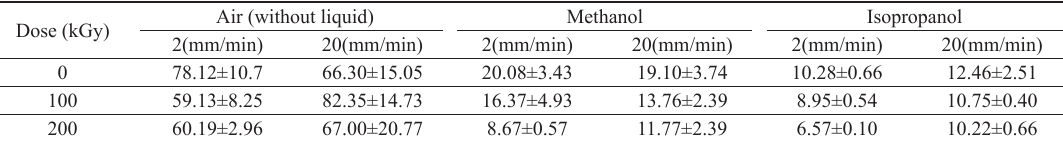
Table 2. Elongation (%) at break of PC under air, methanol and isopropanol as function of absorbed dose, with crosshead speeds at 2 and 20 mm/min. Dose